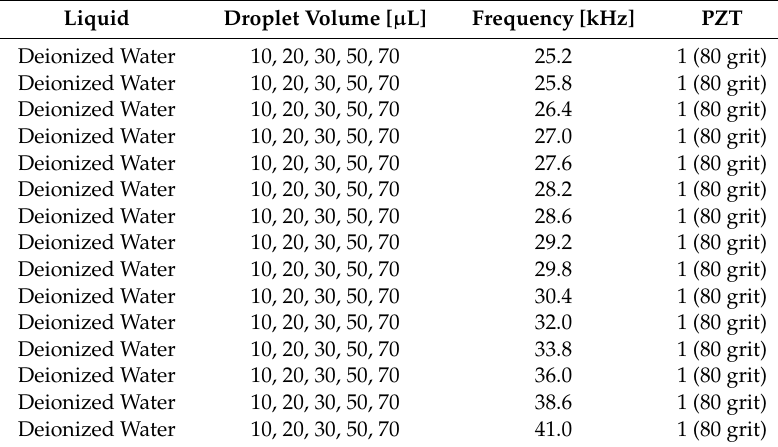
Table A9. Testing parameters used for the experiments conducted with deionized water to investigate the e ff ects of surface roughness using 80 grit